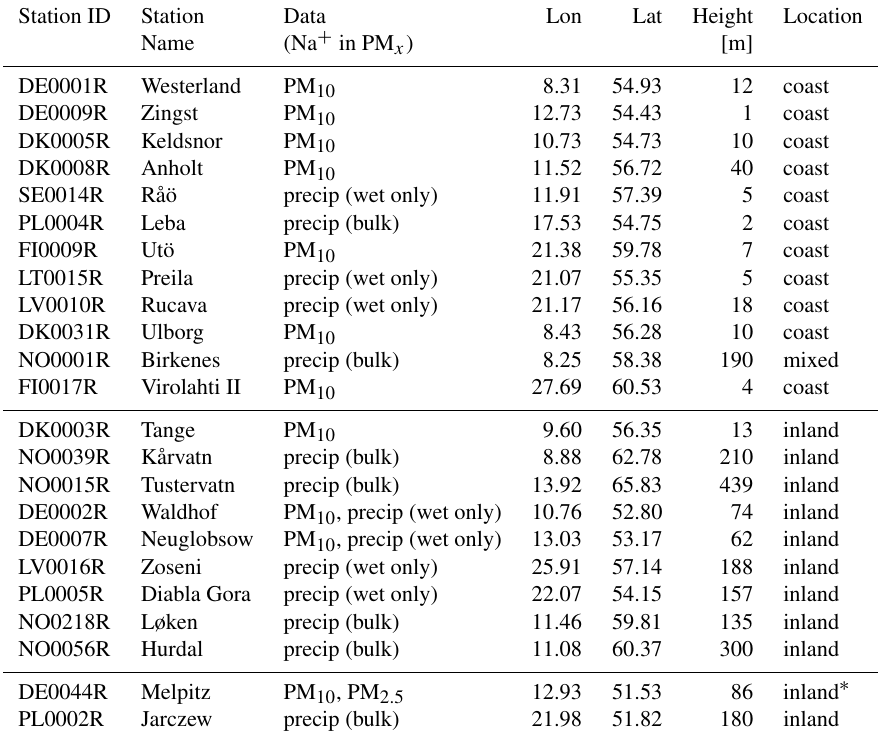
Table 2. EMEP stations that were considered for comparison with the modeled data. The sampler type for the wet deposition (wet only or bulk) is given in brackets in the data column where applicable. The stations are approximately ordered by their distance downwind to the coast. The stations are divided into three groups by vertical lines: (a) at the coast, (b) inland but considerable influence by marine air, and (c) far